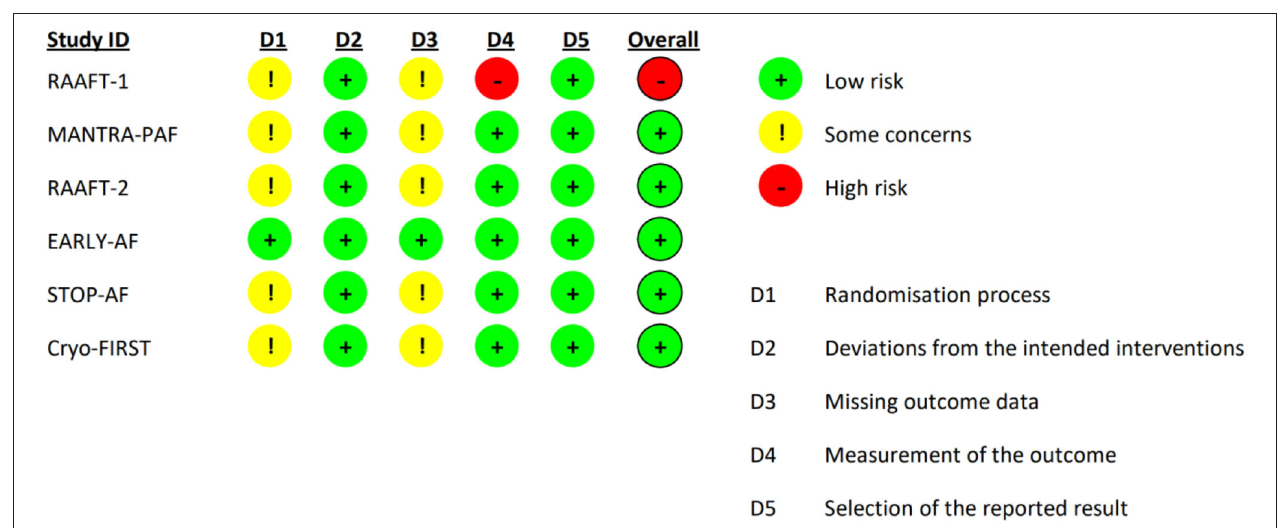
FIGURE 1 | Risk of bias assessment using Cochrane risk of bias 2 (RoB 2) tool.